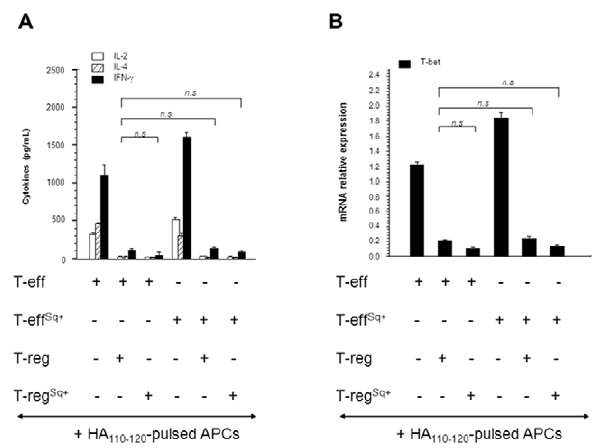
Figure 8. Squalene enrichment of membrane cholesterol in CD4 + Foxp3 + T-reg cells does not alter their suppressogenic function. ( A ) T-reg suppression of HA 110–120 -specific CD4 T-effector (T- eff) cells from untreated or squalene treated (single dose of 180 m g/ mouse) F1 mice (n=4/group) has been tested in an in vitro suppression assay. Isolated HA 110–120 -pulsed APCs (5 6 10 5 ) were co-cultured for 48 h with FACS-sorted HA-specific CD4 + T-eff cells (10 6 cells) and FACS- sorted Foxp3 -GFP + T-regs (10 6 cells) from either untreated or squalene treated (Sq) F1 mice. Various cell co-culture combinations from individual mice are shown in the X-axis, where ( + ) indicates the presence and (–) indicates the absence of cells in the culture system. Cell-culture supernatants from each Treg/T-eff combination were then measured for secreted IFN- c (Th1 cytokine) and IL-4 (Th2 cytokine) by Luminex (Y-axis). No significant changes were observed when compared different co-cultures as specified (brackets, * p values . 0.05). ( B ) Quantitative real-time RT-PCR measured the T-bet mRNA extracted from triplicate wells of each T-reg/T-eff cells combination described in panel A. The Y axis indicates the mean fold increase in mRNA expression level relative to endogenous 18S rRNA control 6 SD. The mRNA relative values were normalized to the untreated T-eff co-cultures with HA- pulsed APCs (reference control sample). Shown is one of two representative experiments. No significant changes were observed when compared different co-cultures as specified (brackets, * p va- lues .